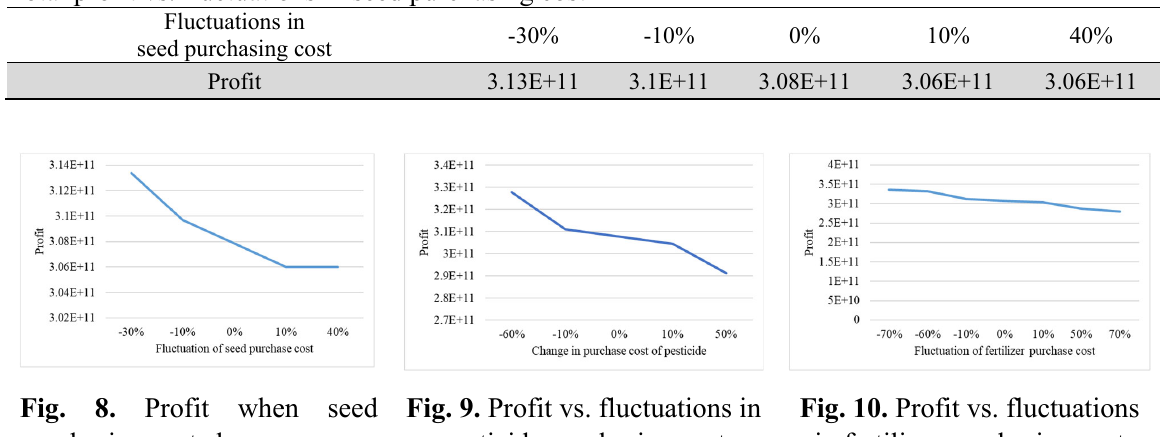
8. Fig. 9. Profit vs. fluctuations in Fig. 10. Profit vs. fluctuations pesticide purchasing cost in fertilizer purchasing